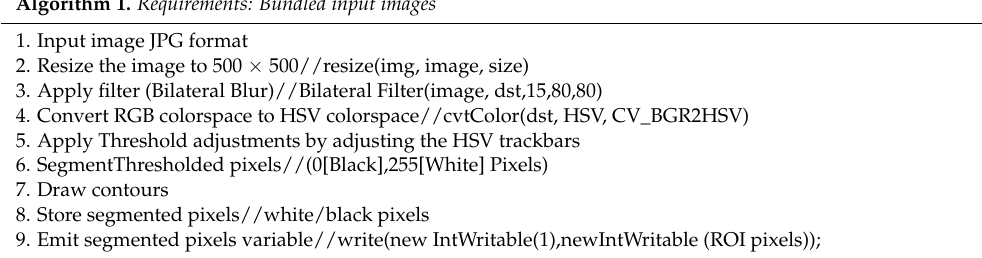
Algorithm 1. Requirements: Bundled input